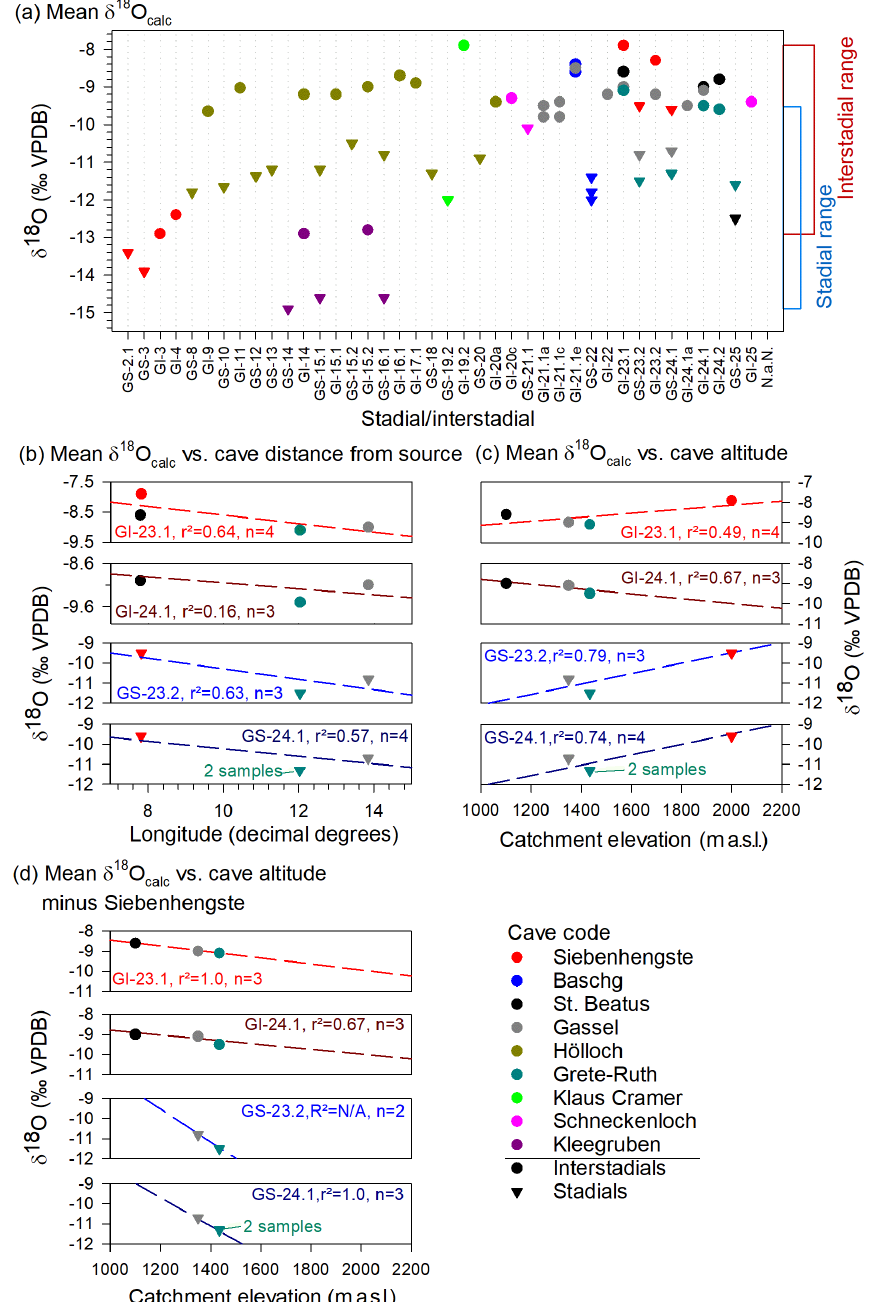
Figure 7. (a) Mean δ 18 O calc for individual caves during specific stadials (triangles) and interstadials (circles). (b) Mean δ 18 O calc values for specific time periods plotted relative to longitude. (c) Mean δ 18 O calc values for specific time periods plotted relative to catchment elevation. (d) Same as (c) minus the data for